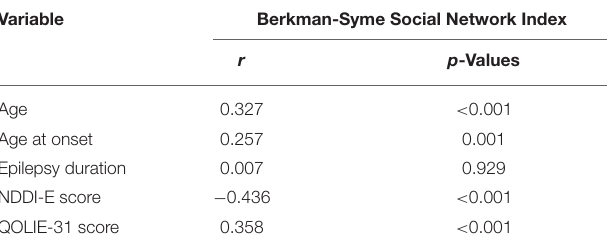
TABLE 3 | Correlation between SNI scores and the continuous variables in